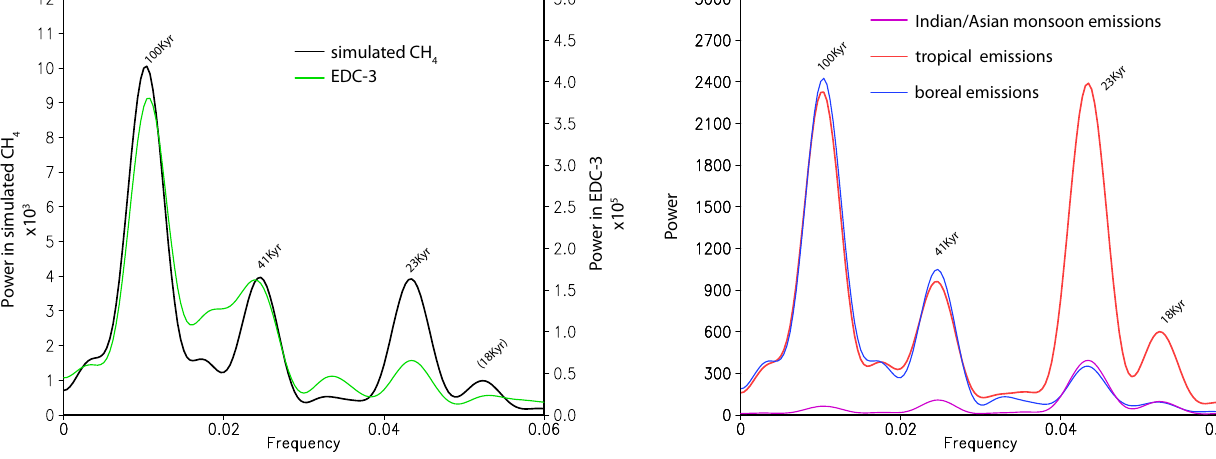
Fig. 6. (left) Spectra for the Epica Dome C atmospheric CH 4 concentrations (green line) and the TRENCH simulated annual global CH 4 emissions (black line), both computed over the time series extending from 650Kyr to 0Kyr BP. (right). Spectra for the time series of the separate emissions from the tropical zone (red line), the boreal zone (blue line) and the Indian/Asian monsoon areas (violet line); the areas are depicted in Fig.